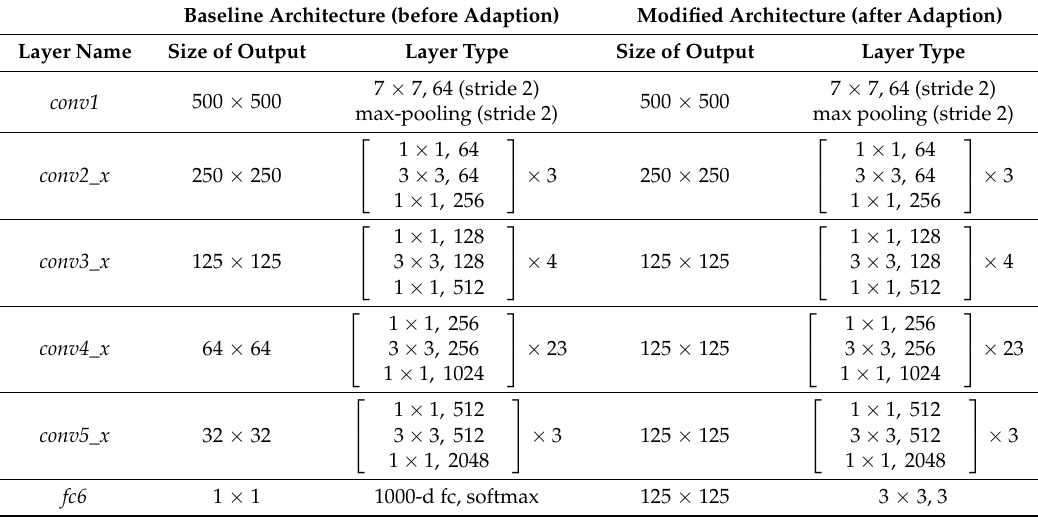
Table 2. Architectures of ResNet before and after adaption.